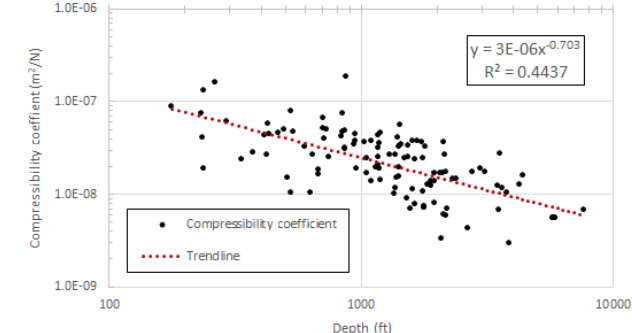
Figure 1. Compressibility as a function of depth for clay samples collected near Houston, Texas, TX, USA (from Gabrysch and Bon- net, 1974).